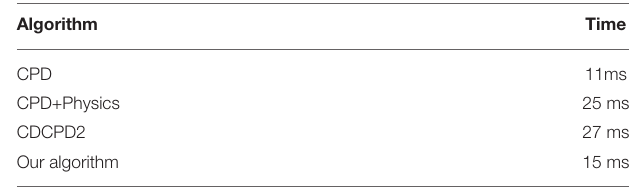
TABLE 2 | Algorithm computation time.